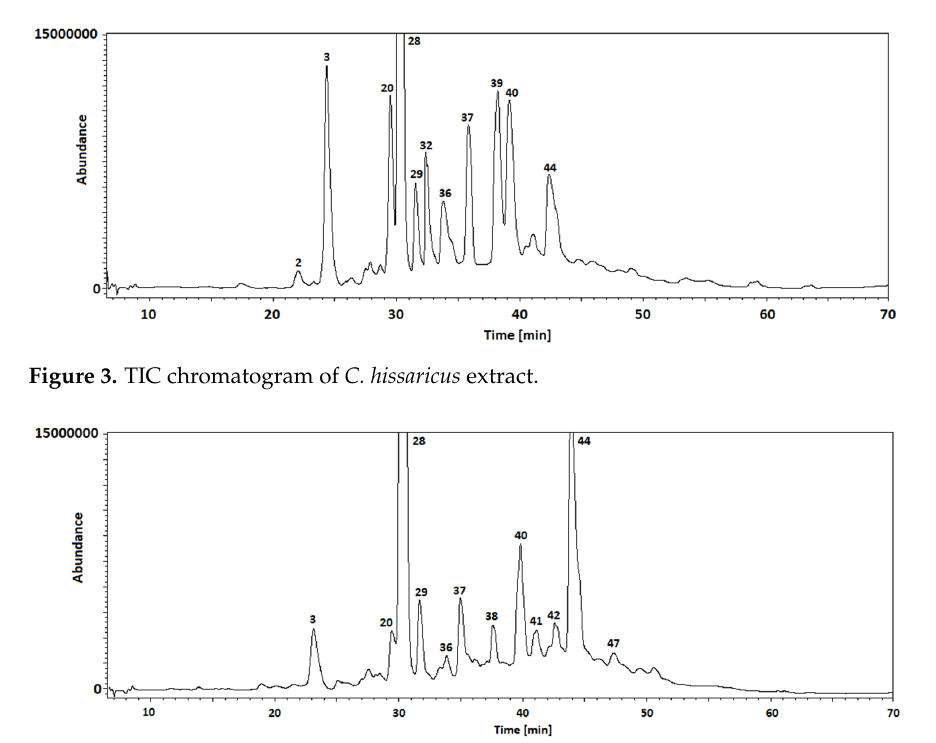
Figure 4. TIC chromatogram of C. hsingshangensis extract. Table 3. Content of active compounds in the leaves of C. hissaricus (CHi) and C. hsingshangensis